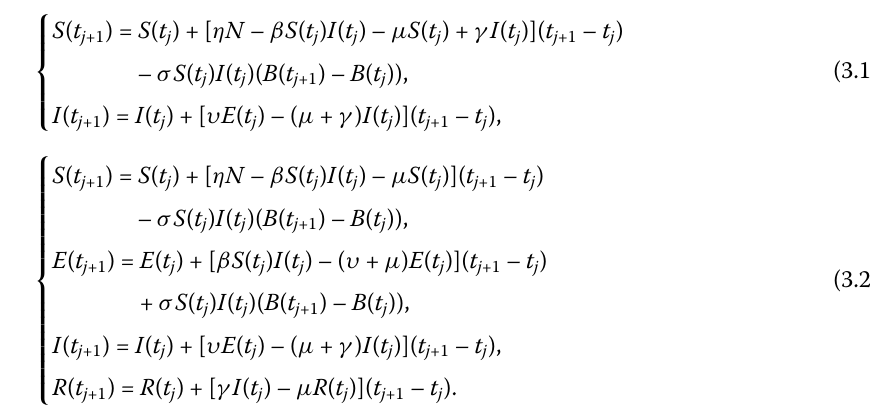
Figure 1 Stability modeled using the parameters N = 1, β = 0.5, σ = 0.3, μ = 0.0007, η = 0.0008, and (a) γ = 0.6 (upper right), (b) γ = 0.7 (upper left), (c) γ = β N η right). The initial condition is ( N ,0) = (1,0) for all of